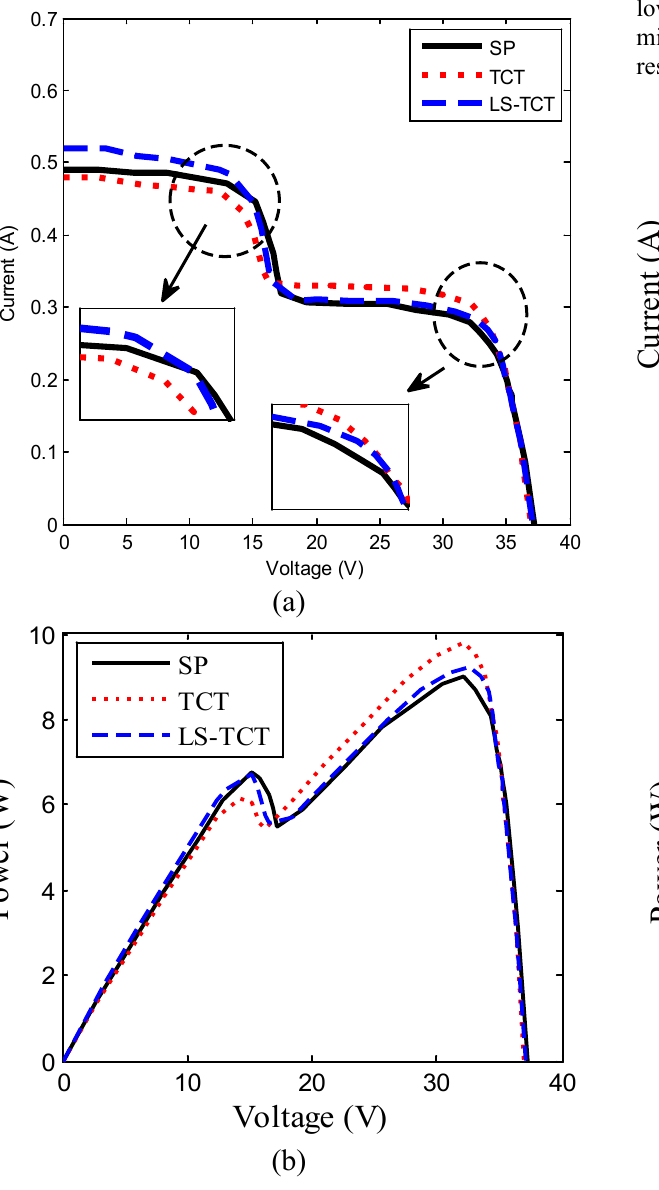
Figure 8. (a) I-V (b) P-V curves of SP, TCT and LS- TCT solar PV array under shading case-2